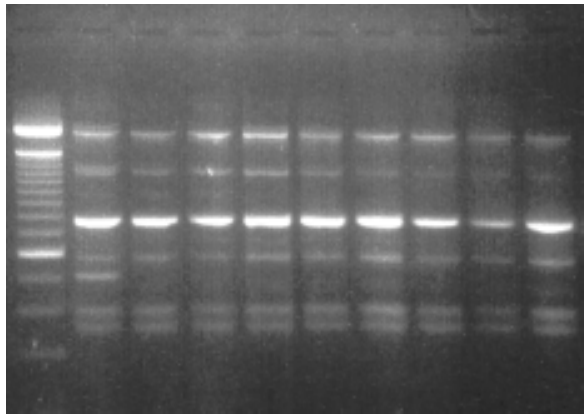
Fig. 3. Fragment lengths (bp) obtained after amplifi- cation with TCG-primer. From left to right: 100 bp DNA Ladder, T12, T17, T32, T36, T39, F1, F2, F11, F22,